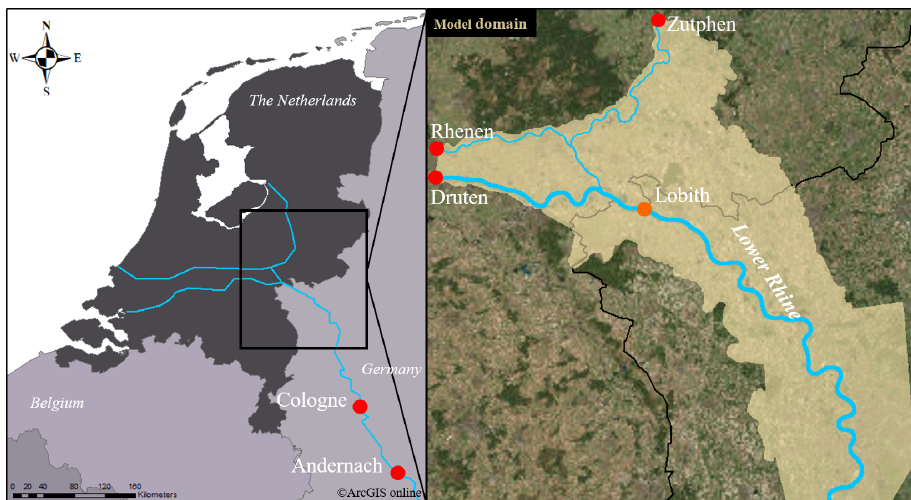
Figure 2. Model domain of the 1-D–2-D coupled model.